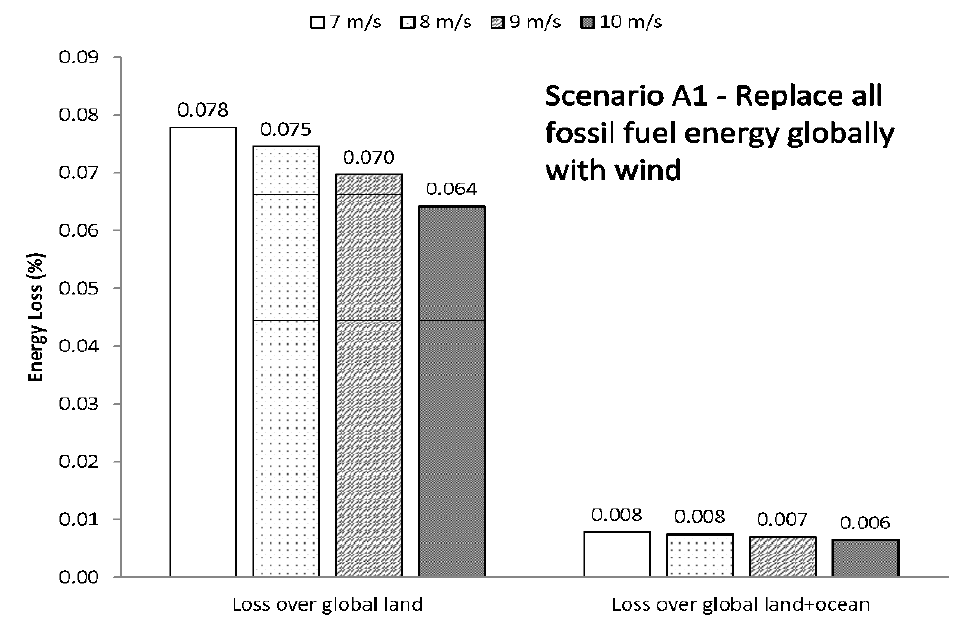
Figure 11. Energy loss (%) for Scenario A1, where wind is used to power global energy. The first set of bars indicates the relative energy loss in the entire boundary layer, while the second set indicates the losses in the boundary layer over just the global land area. The different bars represent the different mean wind speeds, 7, 8, 9, and 10 m/s, with the number of turbines needed for each mean wind speed given in Table